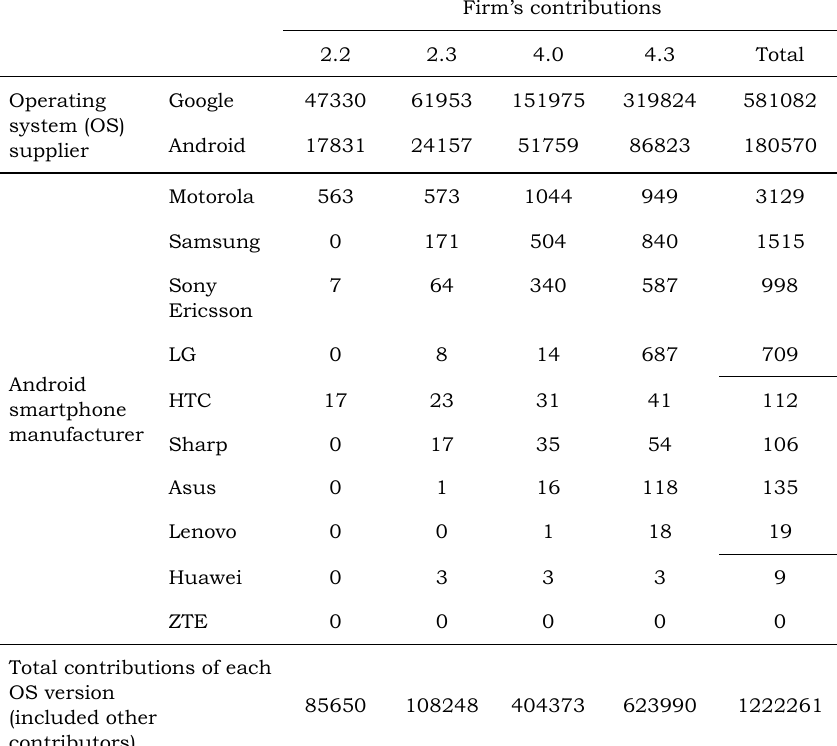
Table 1. Major source code